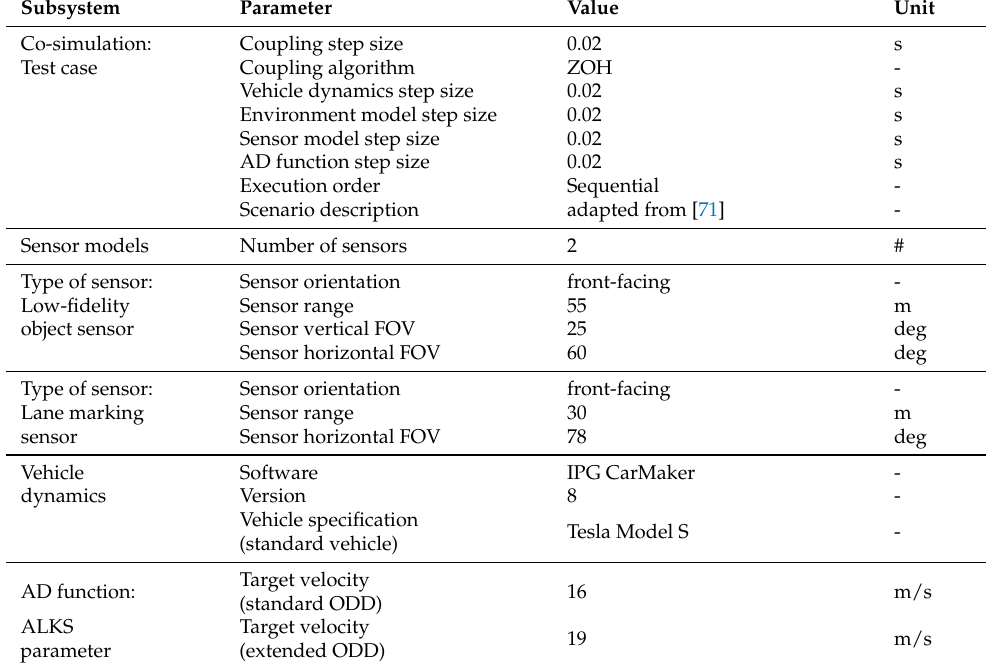
Table 6. Parameters for the two virtual validation frameworks for the